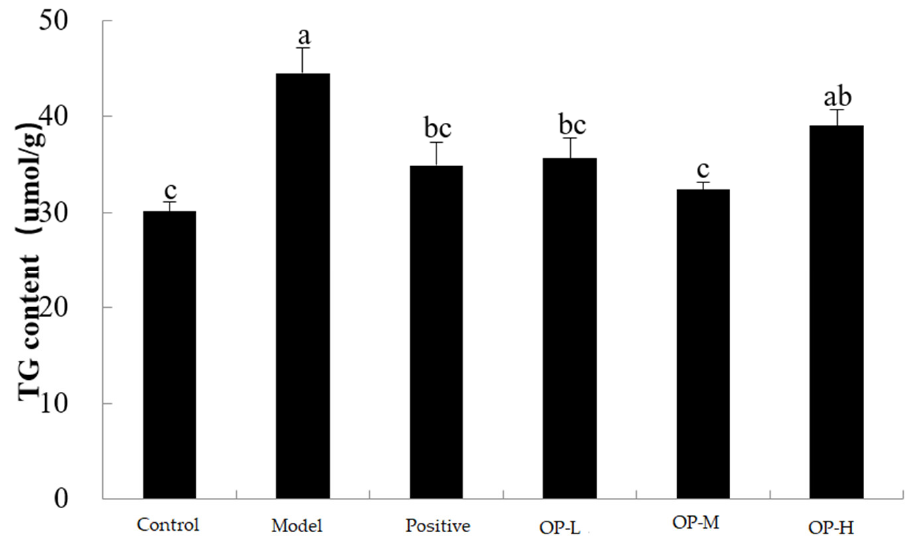
Figure 8. Effect of OP on TG content (means ± SD, n = 10). Bars with different superscripts (a, b, and c) were significantly different ( p < 0.01) according to ANOVA using the SPSS software and means were compared by Duncan’s multiple comparison post-test.